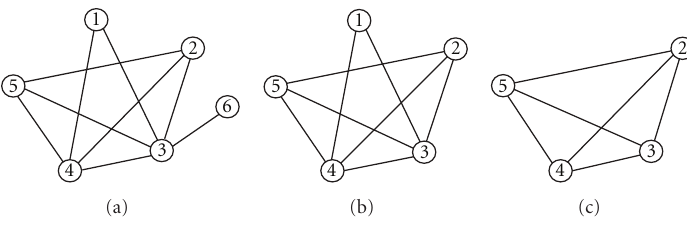
Figure 1: The illustration of k -cores of a graph. (a) Graph G ; (b) 2-core of G ; (c) 3-core of G , it is also the highest k -core of G .